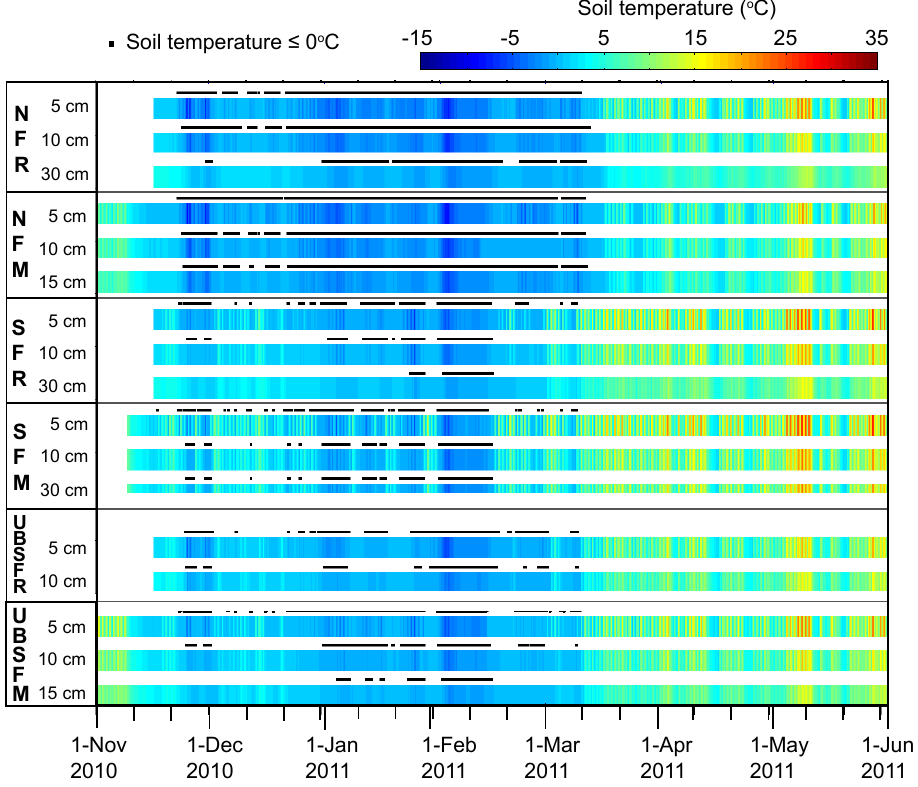
Fig. 5. Soil temperature time series from Decagon 5TE sensors as colored bars with black dots denoting frozen soil. Note that the 2-min temporal resolution gives the black dots denoting frozen conditions the appearance of broken